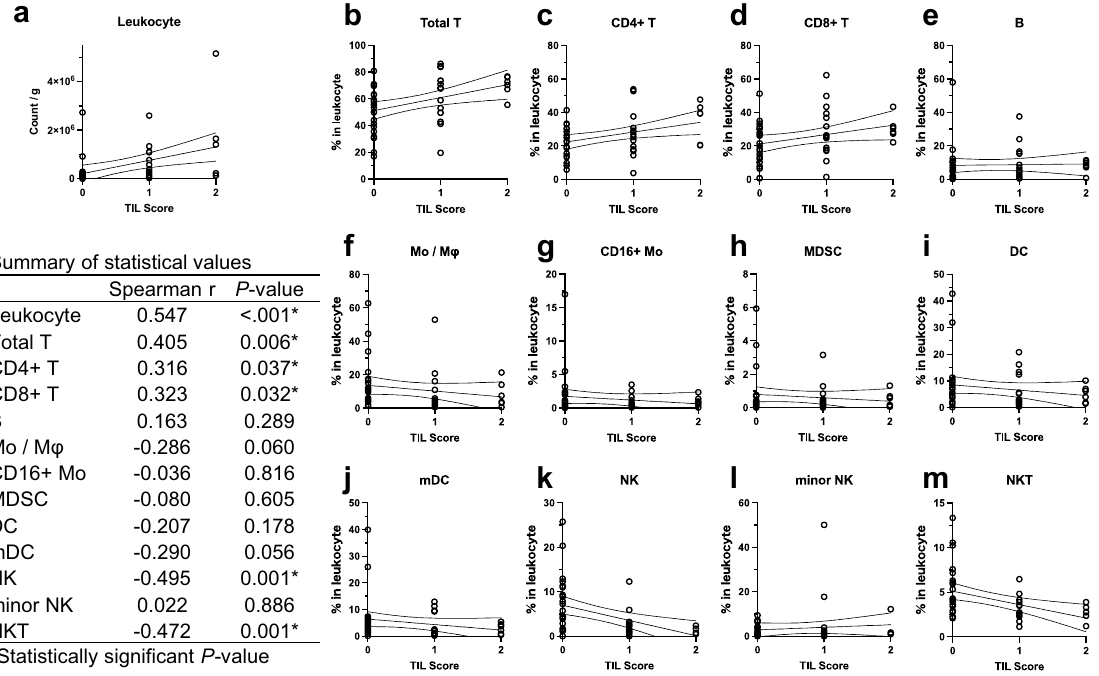
Figure 2. hTIL is associated with the degree of leukocyte infiltration in tumor tissues and leukocyte composition. For cases with tumor tissue samples, a correlation analysis was performed for ( a ) hTIL scores and leukocyte densities (count/g) in tumor tissues, ( b – m ) hTIL scores, and percentages of each immune cell fraction in the tumor tissues. The X- and Y-axes show the hTIL scores and ( a ) leukocyte densities (count/g) or ( b – m ) the percentages of the immune cell fractions in the tumor tissue, respectively. The lines in the graph indicate the regression line with a 95% confidence band. The relationship between these values was analyzed using the Spearman correlation test. Values of P < 0.05 are considered statistically significant. Statistical values are summarized in the table on the left side of the